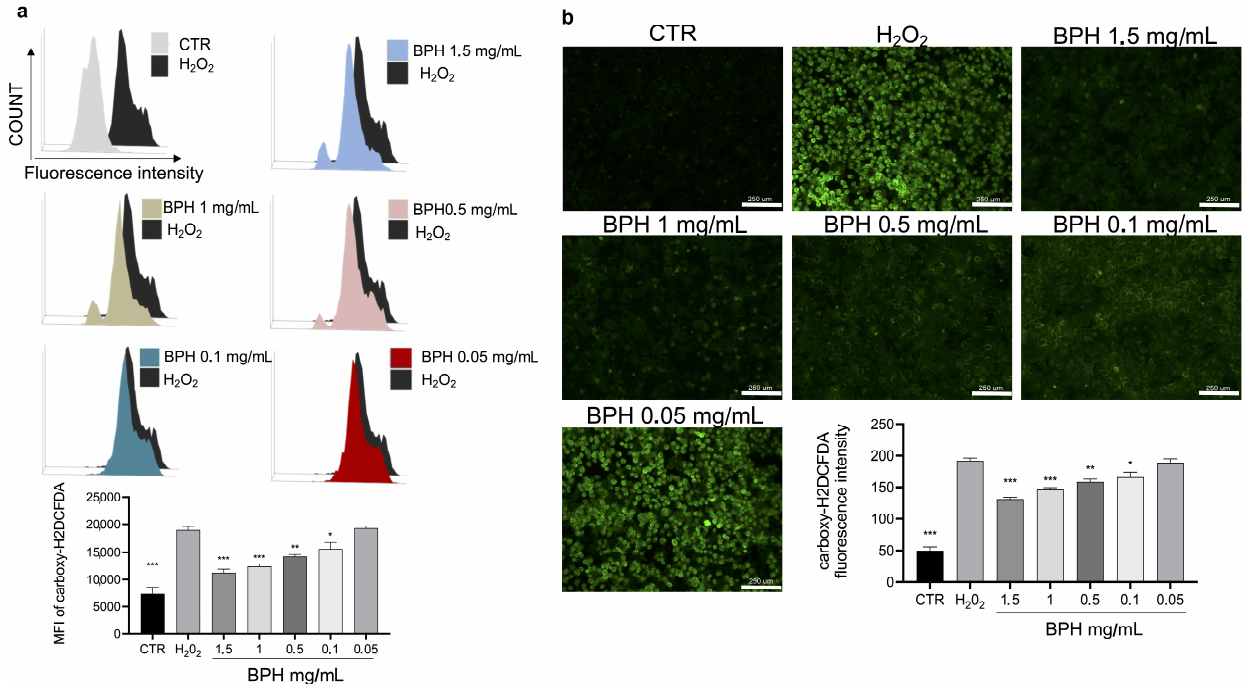
Figure 3. ( a ) Flow cytometry analysis of carboxy-H2DCFDA probe fluorescence of each experimental group compared to H 2 O 2 group. ( b ) Fluorescence microscopy images of carboxy-H2DCFDA positive cells for each experimental condition. Data (mean ± SE) are representative of at least three independent experiments. *** p < 0.001 vs. H 2 O 2 ; ** p < 0.01 vs. H 2 O 2 ; * p < 0.05 vs. H 2 O 2 .